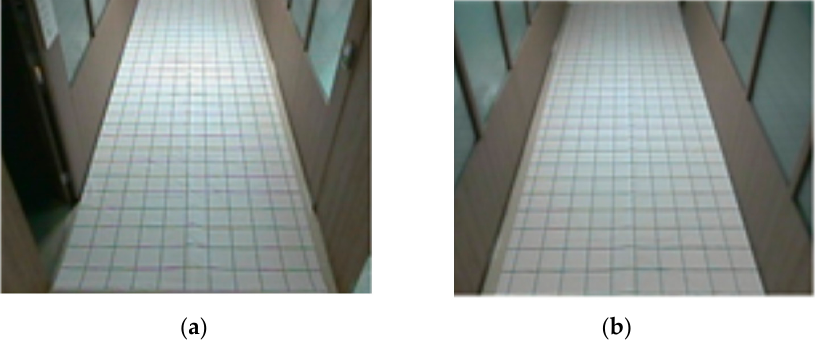
Figure 8. Grid placard for measuring the position error of the visually detected object area ( a ) camera 1; ( b ) camera 2.